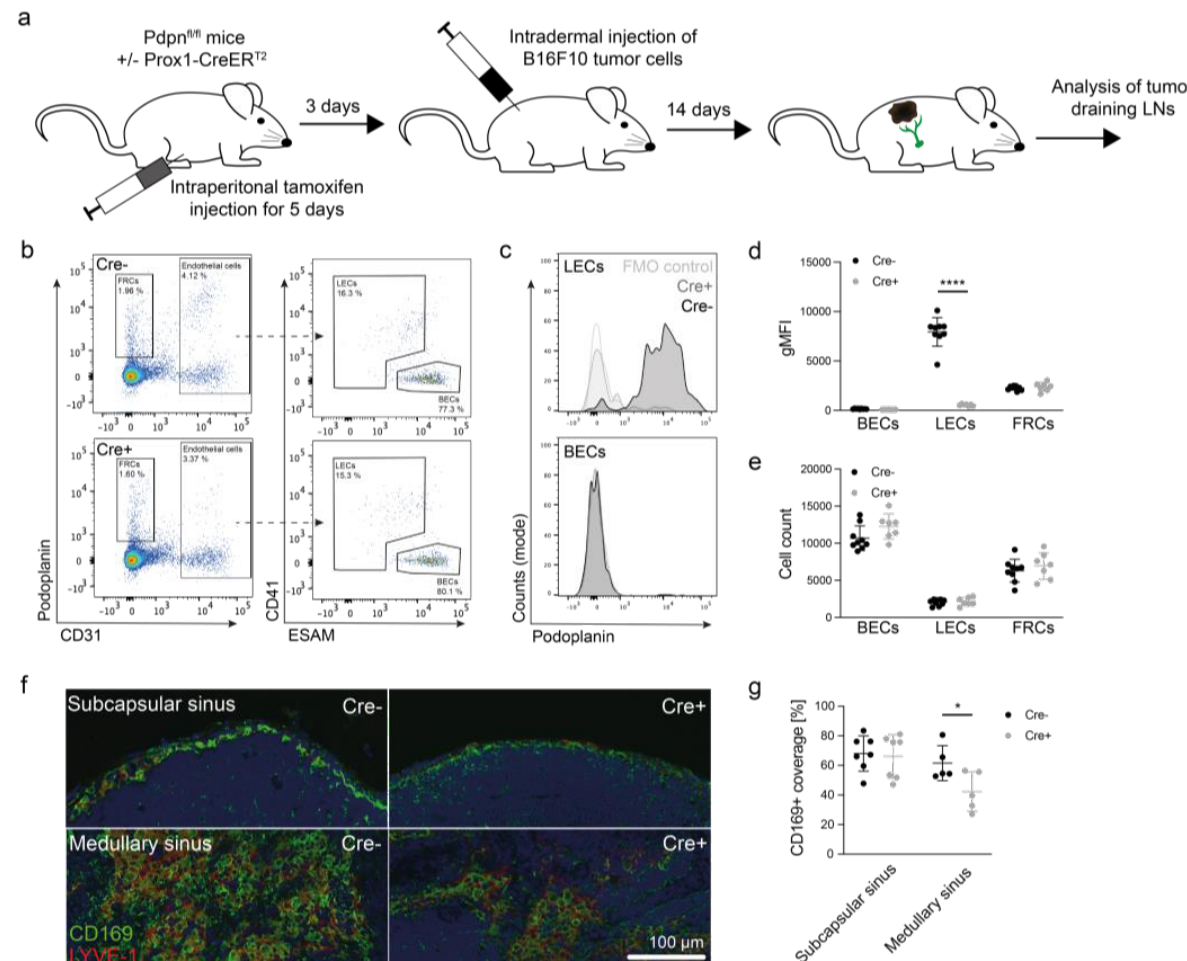
Figure 5. Lymphatic podoplanin regulates abundance of medullary sinus macrophages (MSMs) in tumor-draining lymph LNs. ( a ) Schematic representation of the experimental set-up. Pdpn fl/fl x Prox1-CreER T2 mice were treated for 5 consecutive days with tamoxifen. Cre− littermates served as controls. Subsequently, B16F10 cells were implanted intradermally, tumor growth was monitored, and tumor-draining LNs (inguinal and axillary) were analyzed by flow cytometry on day 14. ( b ) Representative LEC gating in Cre− and Cre+ mice. Stromal cells (pregated as CD45 − living singlets) were stained for podoplanin and CD31 to detect FRCs and endothelial cells, respectively. Subse- quently, LECs were distinguished from BECs with a combination of CD41 (Itga2b) and ESAM. ( c , d ) Representative histogram ( c ) and quantification ( d ) of podoplanin expression in LN stromal cells ( N = 9 Cre− /7 Cre+). ( e ) Number of LN stromal cells in tumor-draining LNs determined by flow